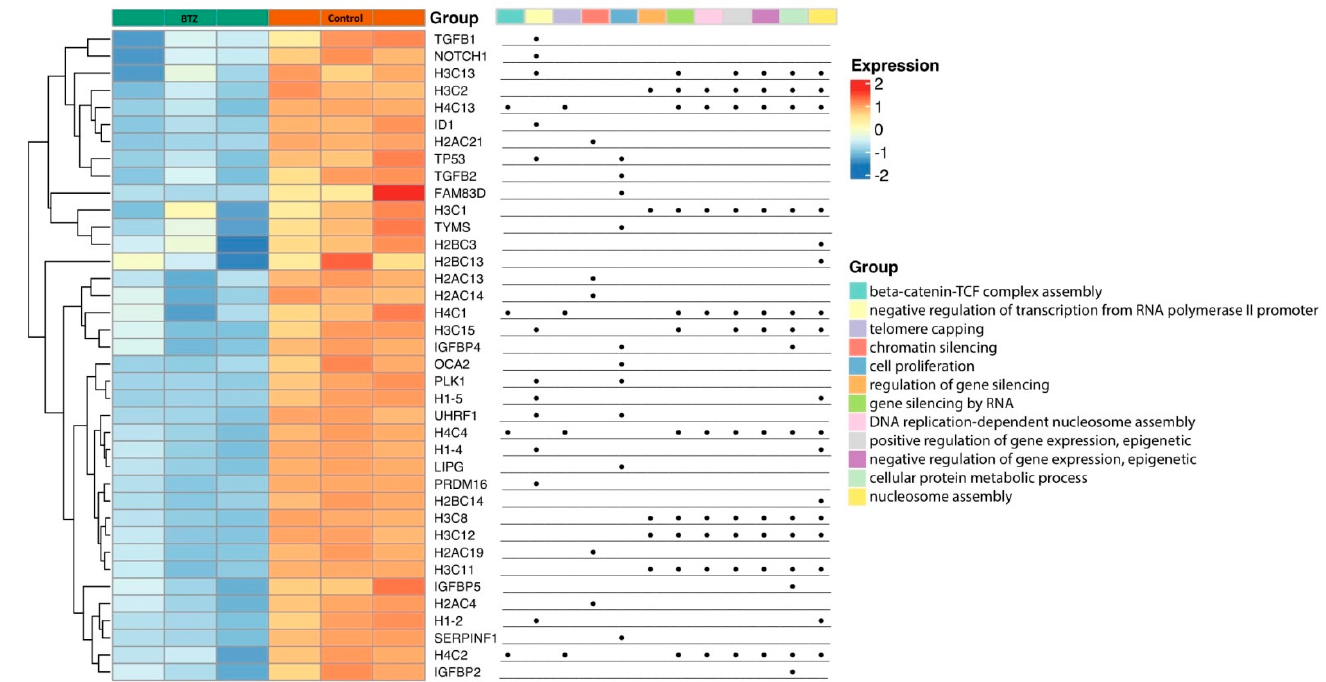
Figure 3. Expression of selected genes presented as a heatmap. Red color means increased gene expression and blue decreased gene expression. In addition, specific genes have been assigned to regulate biological processes (the dot indicates the gene’s participation in a specific process).